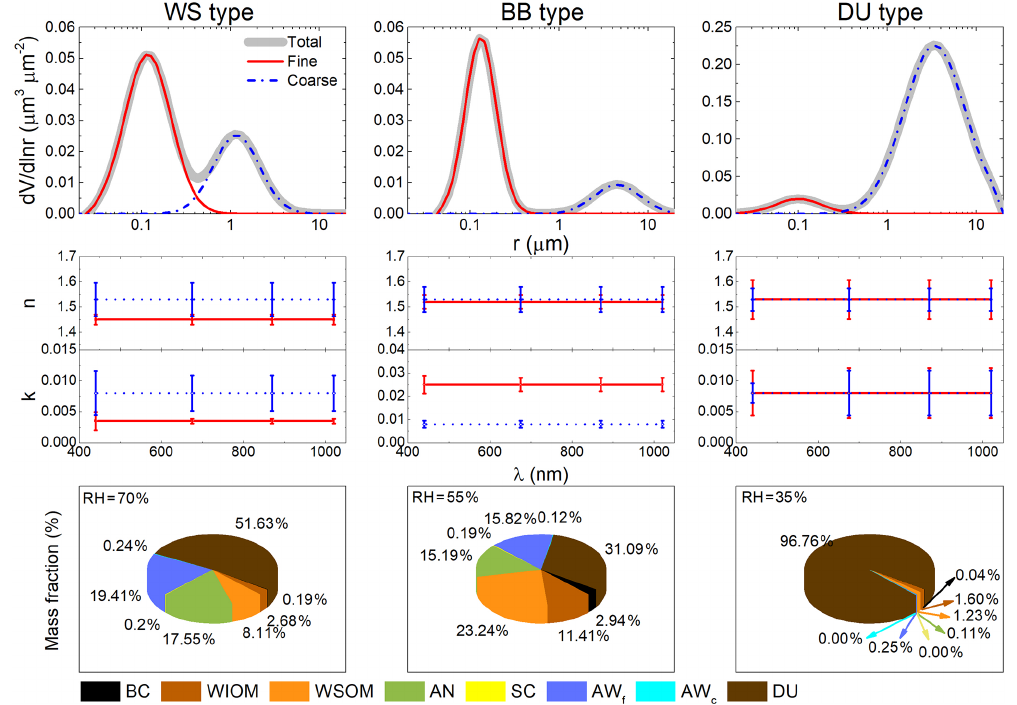
Figure 6. The fine- and coarse-mode volume size distribution, complex refractive index, and aerosol components describing the aerosol models used in the synthetic case study (WS: water soluble, BB: biomass burning, DU: